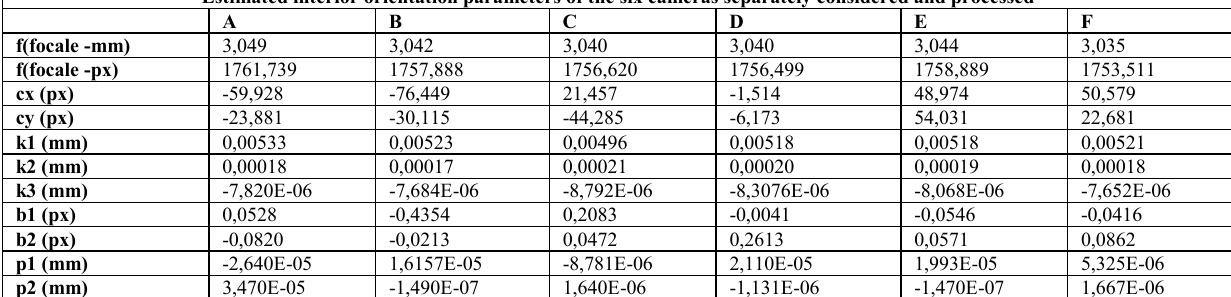
Table 2. Estimated interior orientation parameters of the six cameras separately considered and